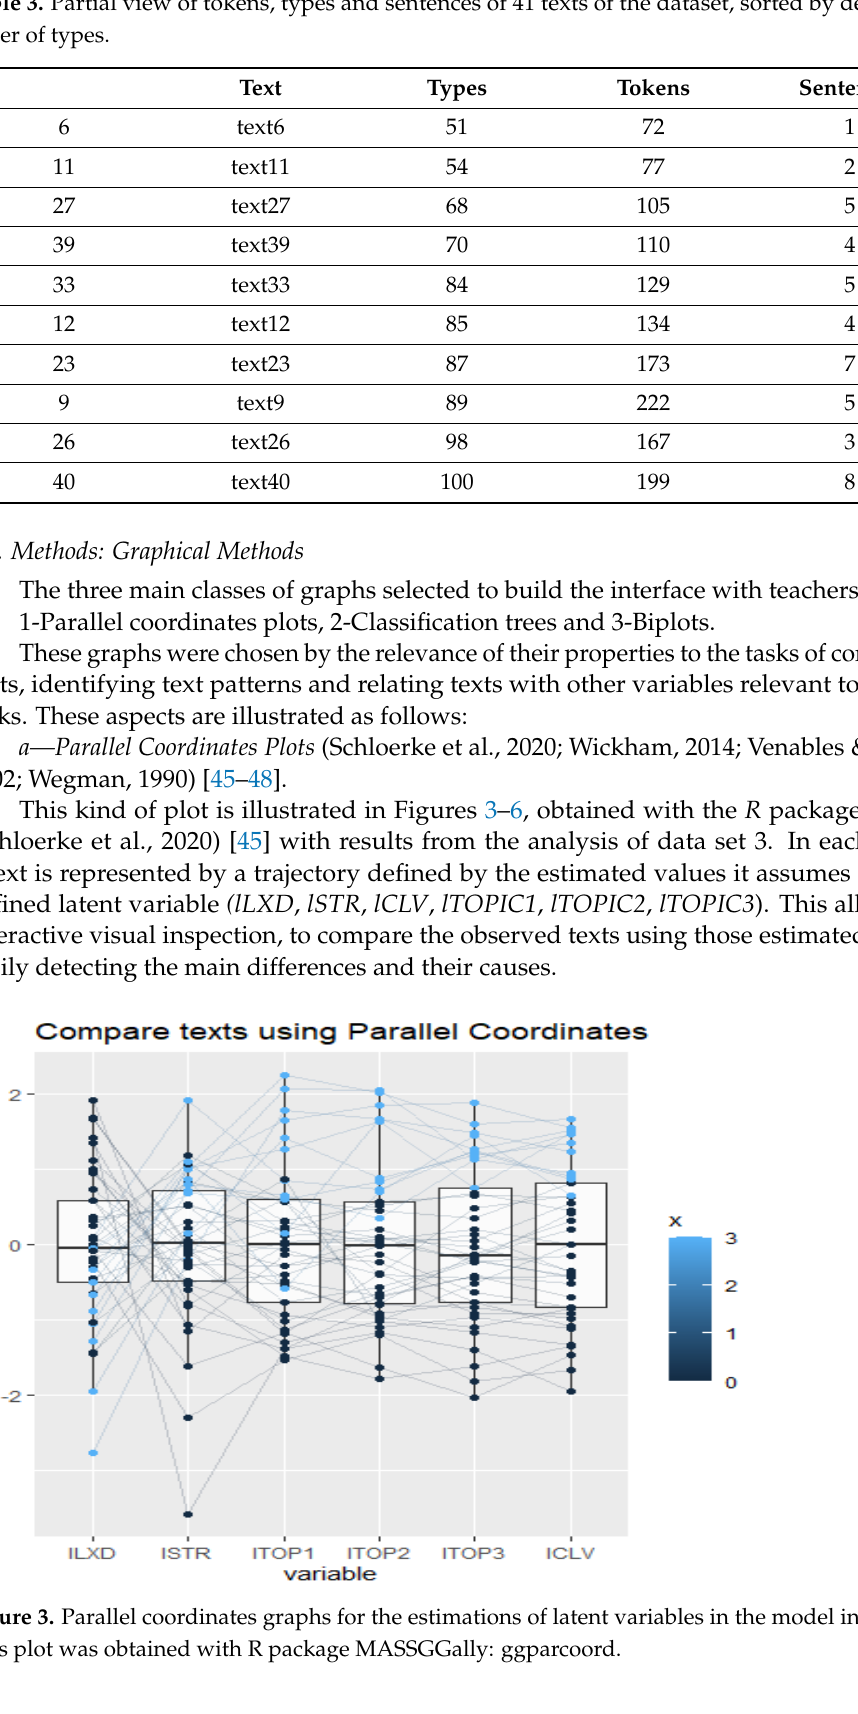
Figure 4. With the data in Figure 3, texts belong to the first quartile of l CLV, R package MASS . Figure 5. With the data in Figure 3, texts belong to the second quartile of l CLV, R package MASS.